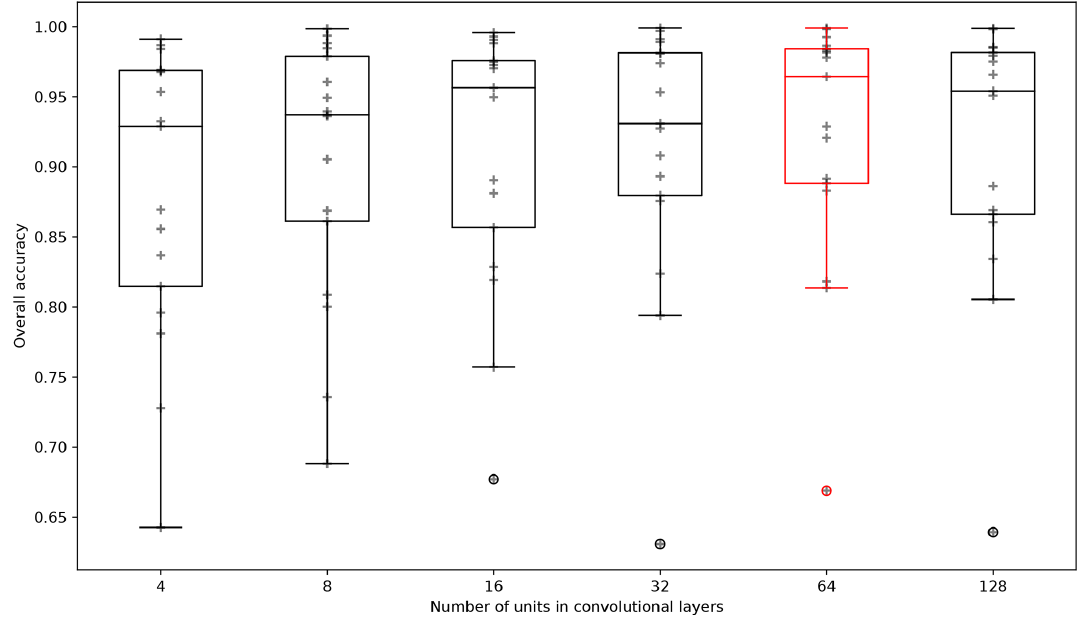
Figure 5. The graph illustrates temporal cross-validation results using box plots. Each box plot contains 17 overall accuracy values and if read from left to right, each box plot corresponds to 4, 8, 16, 32, 64, and 128 convolutional units in each convolutional layer. Red highlights the best architecture with 64 convolutional